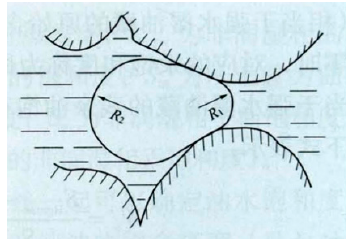
Figure 2. A sketch of the Jamin effect.